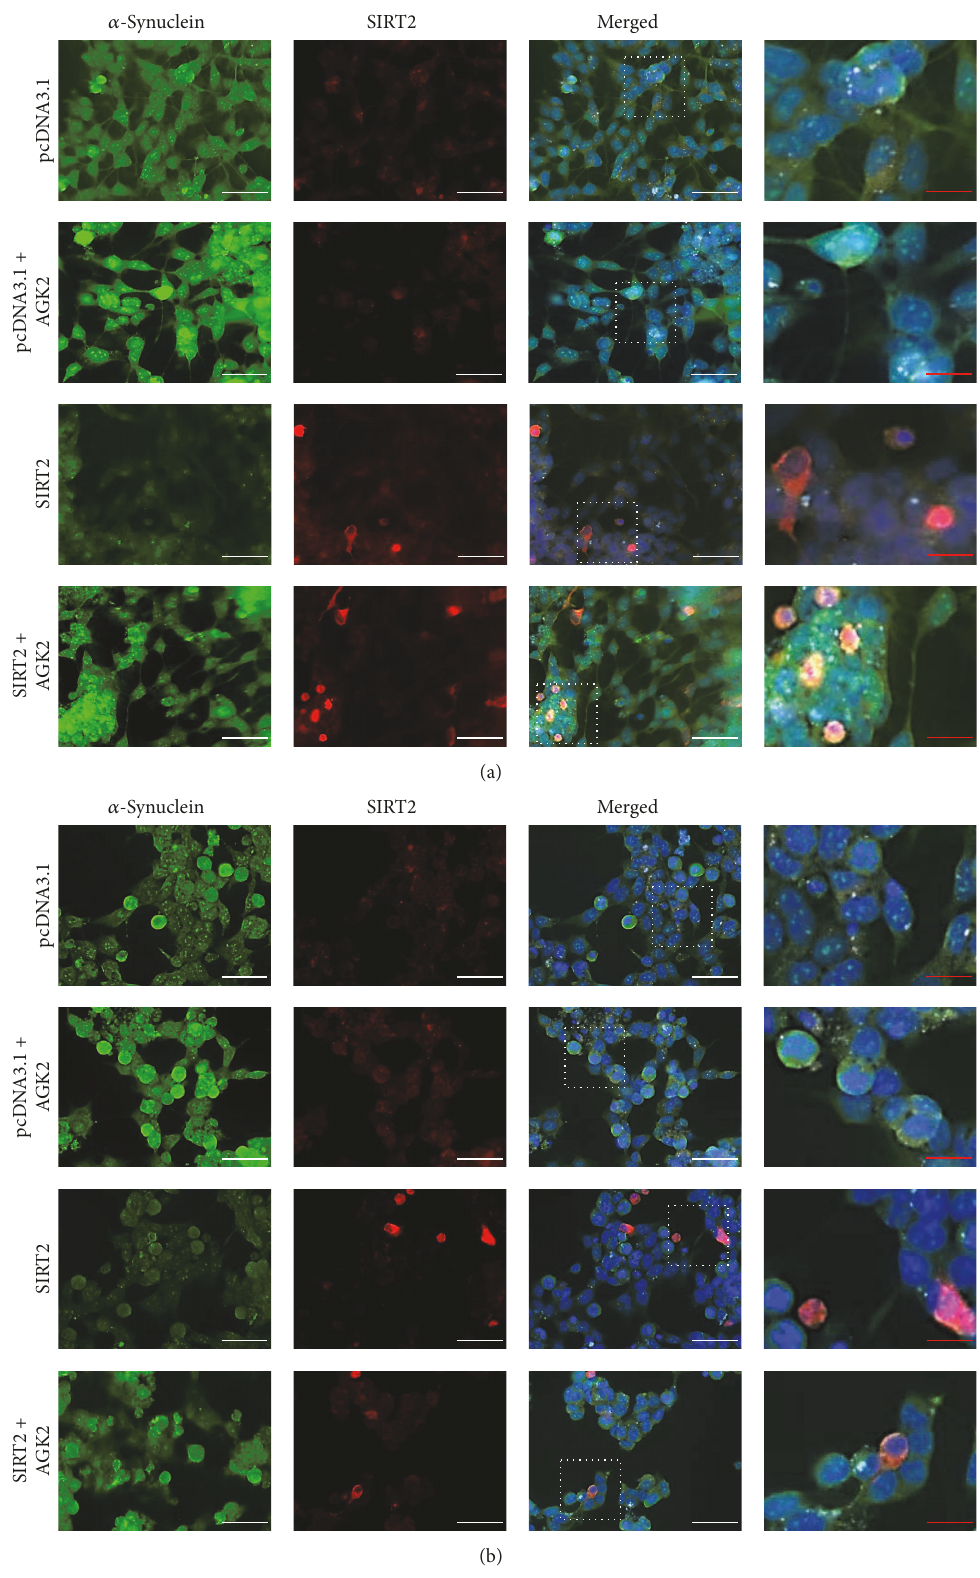
Figure 4: Localisation of SIRT2 and 𝛼 -synuclein in rotenone treated SH-SY5Y cells. Cellular distribution of SIRT2 and phospho- 𝛼 - synuclein was determined using fluorescent immunocytochemistry. Images show 𝛼 -synuclein immunostaining, SIRT2 immunostaining, and all staining merged including DAPI in 20 𝜇 M rotenone treated cells. Scale bars, white scale bar = 50 𝜇 M and red scale bar = 20 𝜇 M; magnification: 40x. (a) represents 0.2% DMSO and (b) represents 20 𝜇 M rotenone treated SH-SY5Y